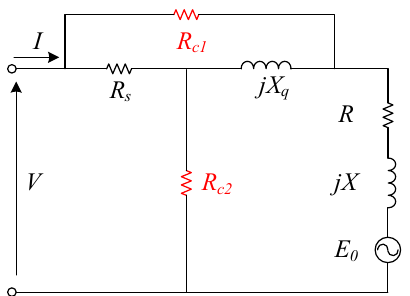
zero and the ECM, as in Figure 7, also can be adopted.